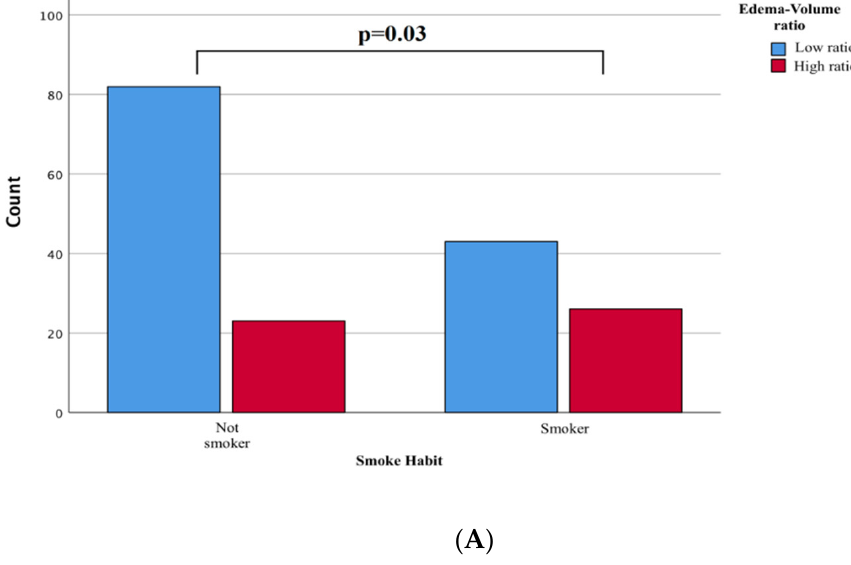
Figure 2. Pearson’s bivariate correlation plot demonstrating the presence of a positive correlation between the contrast ‐ enhancing lesion volume and the edema volume as measured in T2 ‐ FLAIR ( p < 0.01).